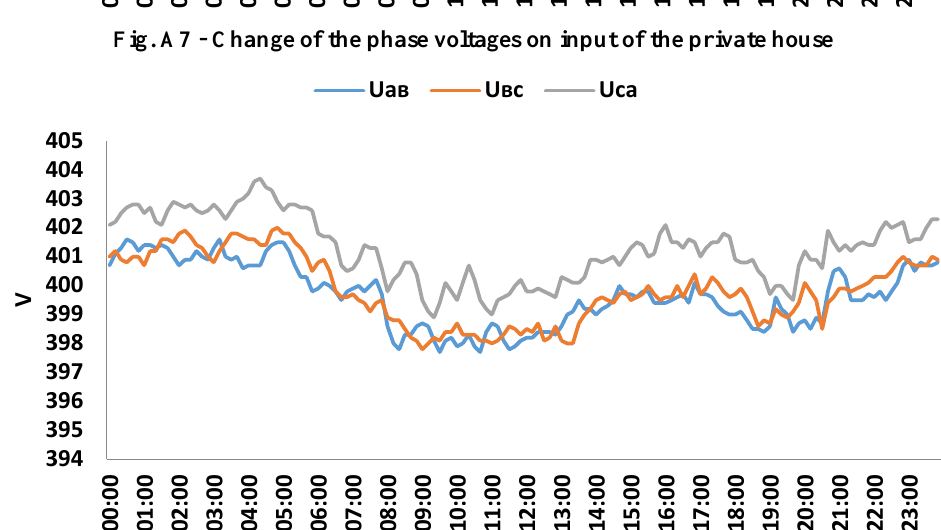
Fig. A8 - Change of interphase voltages on input of the private house